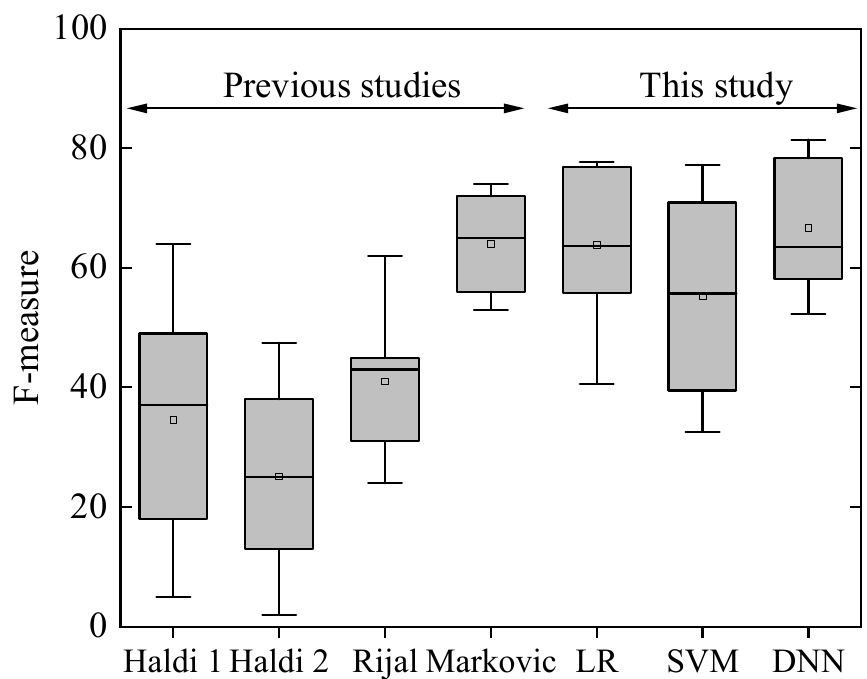
Figure 14. Comparison of F-measure between this study and previous studies.